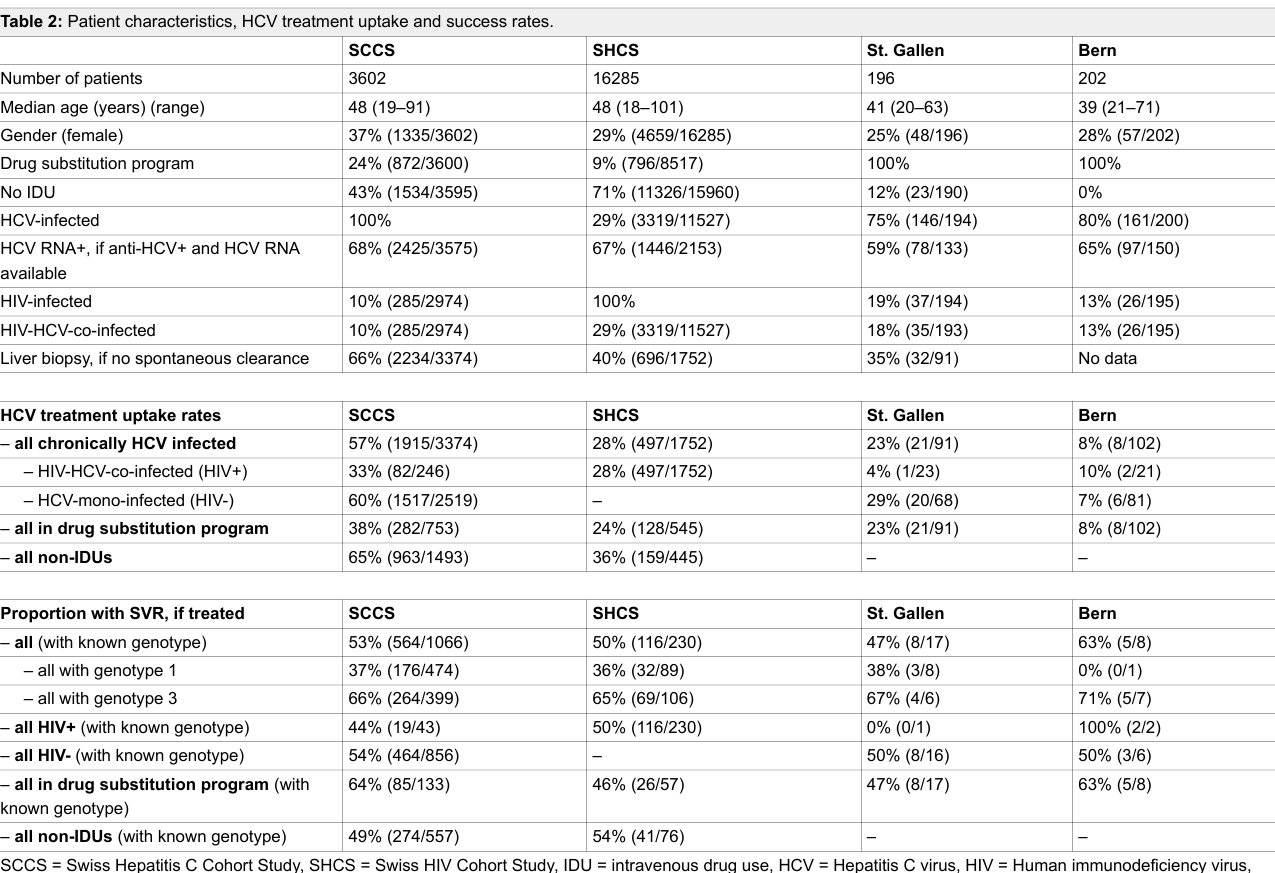
Table 2: Patient characteristics, HCV treatment uptake and success rates.